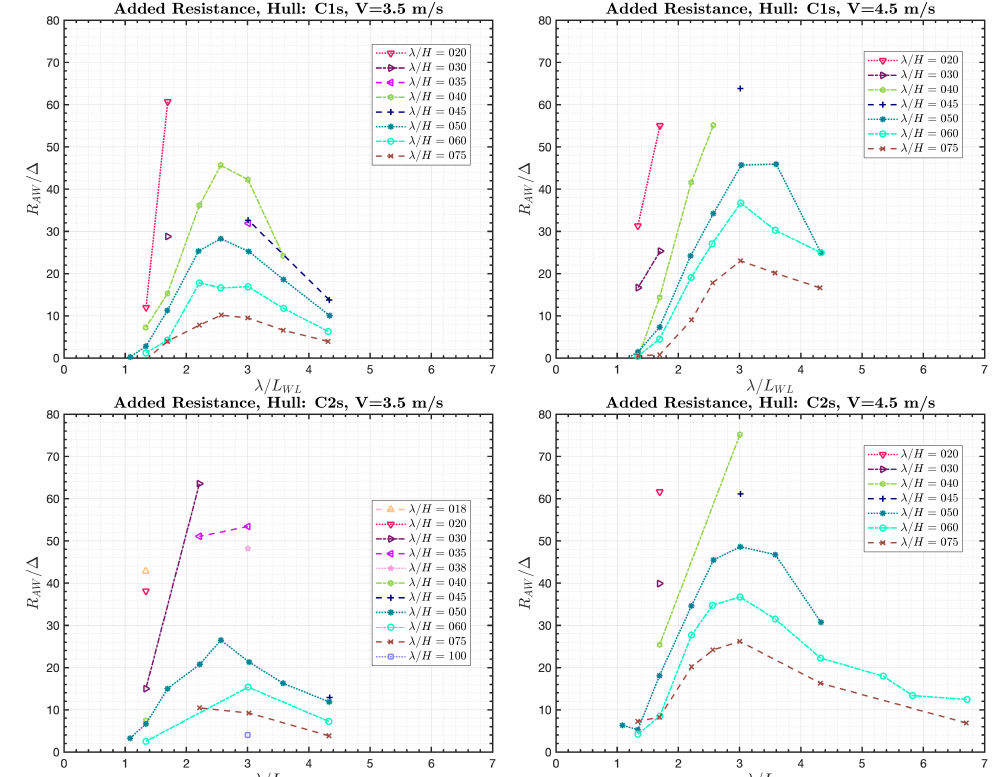
Figure 5. Added resistance vs. λ / L WL